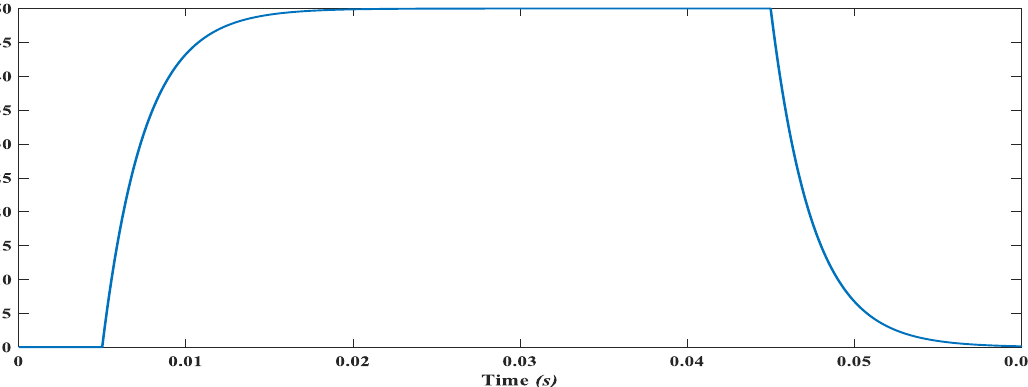
Figure 26. Angular rotation about z-axis applied to the proposed MEMS gyroscope.